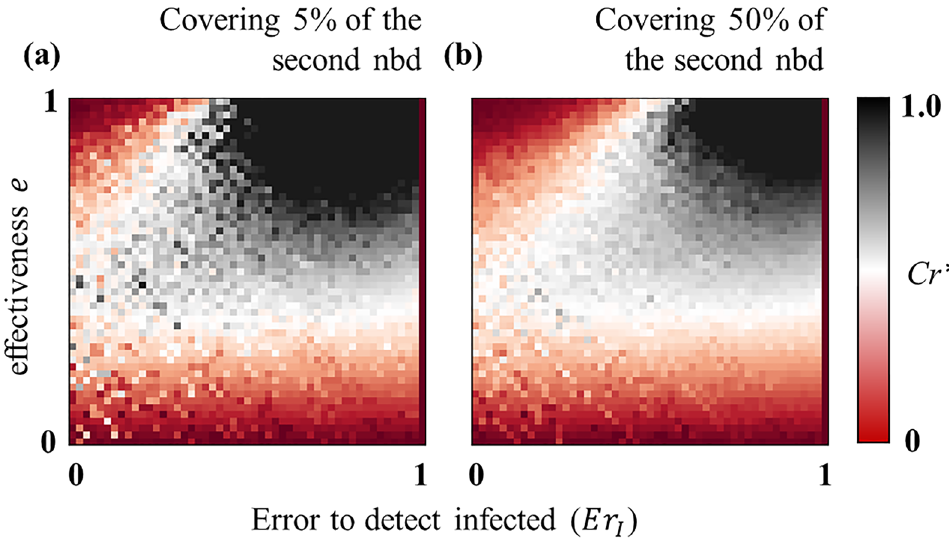
Figure 6. Examining the social benefit regarding the expansion of the vaccination target. The critical vaccination cost Cr ∗ , as a function of detecting error and e , at which the ASP estimated in the expansion (to the second neighborhood) strategy (for vaccination) is equivalent to that in the default case (covering only the first neighborhood). Expanding vaccination targets makes the total social cost lower than the default case whenever ≈ 1 in the black regimes in both panels which demonstrates that expansion strategy can reduce Cr < Cr ∗ . C ∗ r the overall social cost in those scenarios. On the other hand, the red regions (in both panels) illustrate that ≈ 0 , which means that it would not be beneficial to expand vaccination targets in those cases as C r ≥ 0. C ∗ r Relevant parameters values are stated in Table